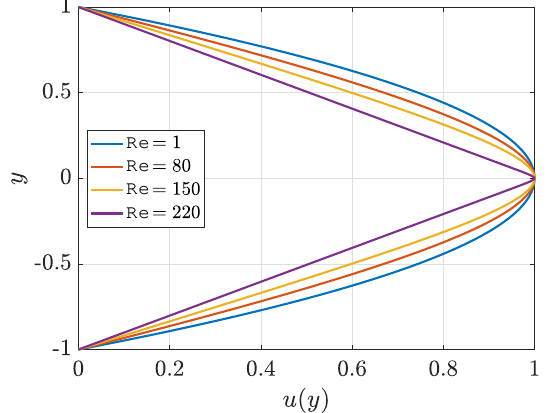
Figure 6. Velocity profiles (18) for various Re < Γ 2 , Γ =